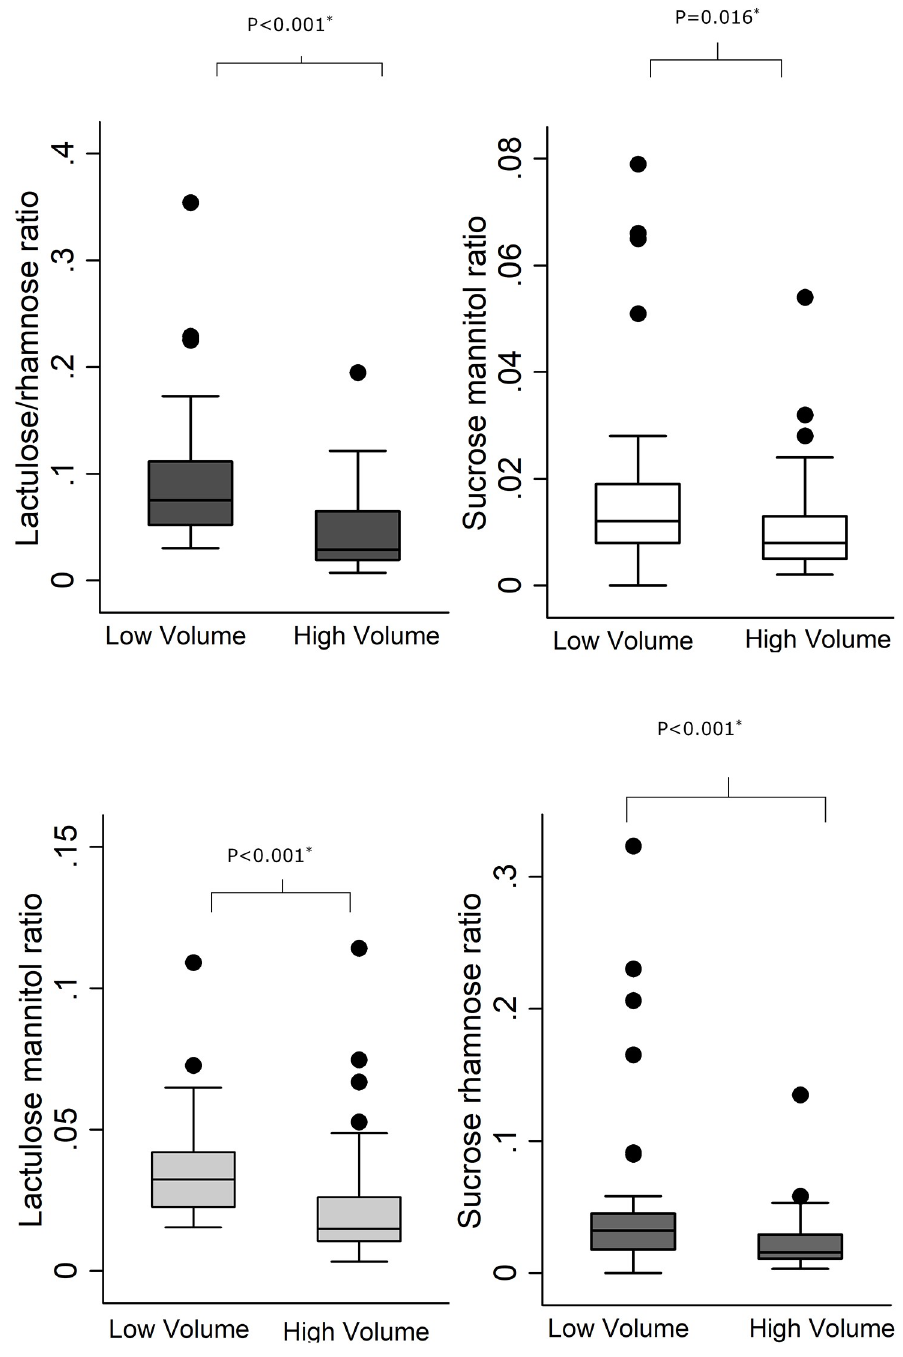
Fig 2. Sugar recovery ratios at low and high urinary volumes; Lactulose rhamnose ratio; sucrose-mannitol ratio; lactulose-mannitol ratio; sucrose-rhamnose ratio.